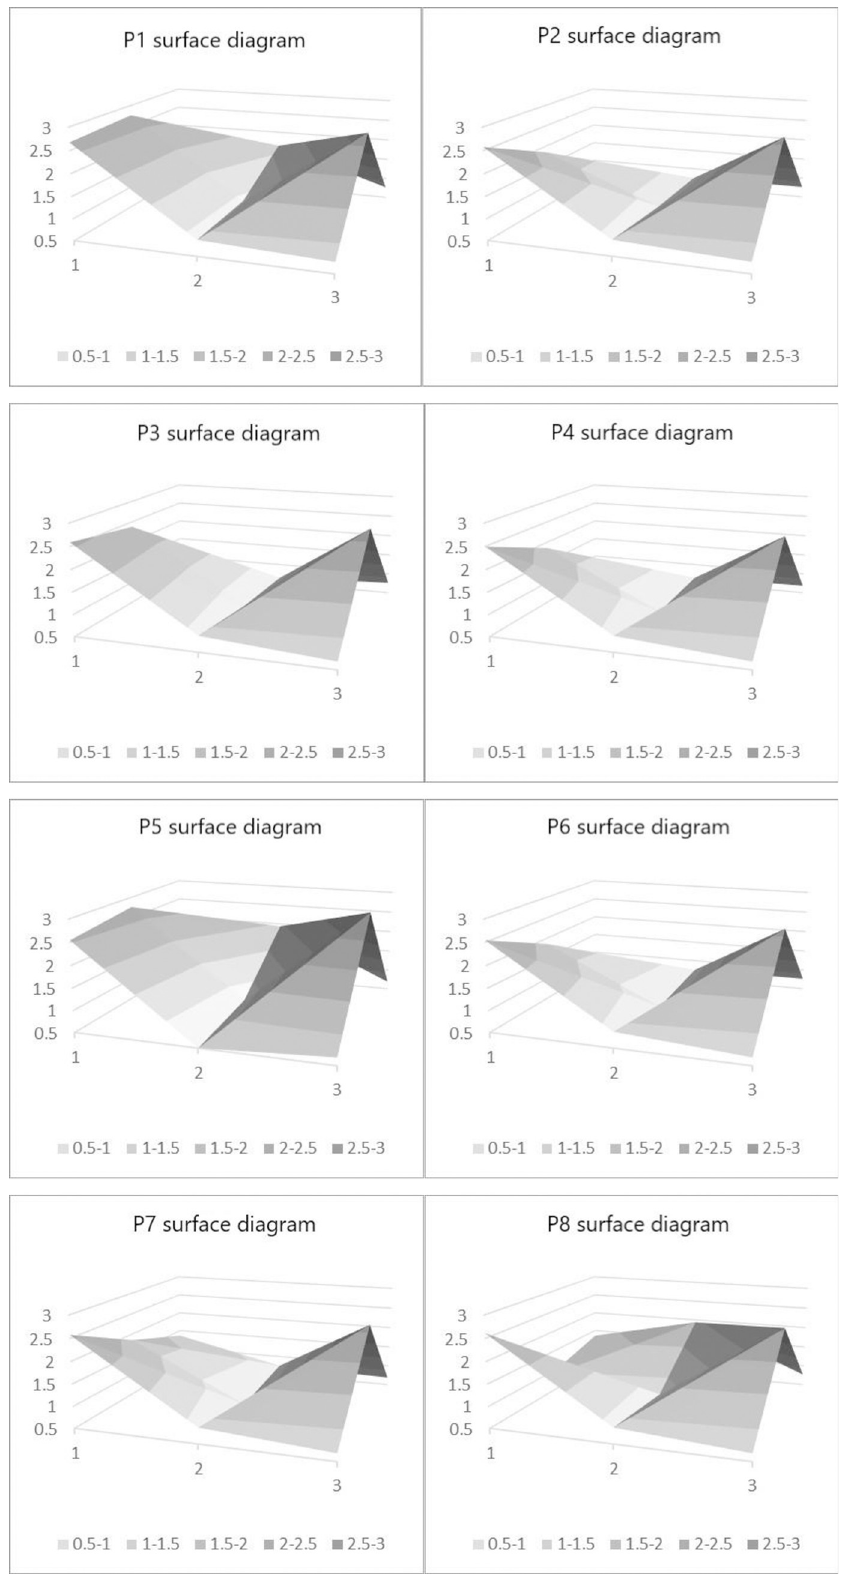
Fig 4. PMC-AE surface diagram of each